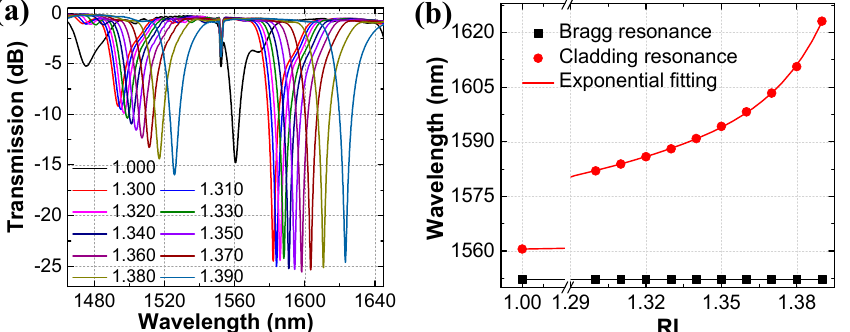
Figure 4. ( a ) Spectral evolution with the refractive index (RI) increasing; ( b ) RI responses of Bragg resonance and cladding mode resonances of the hybrid grating.